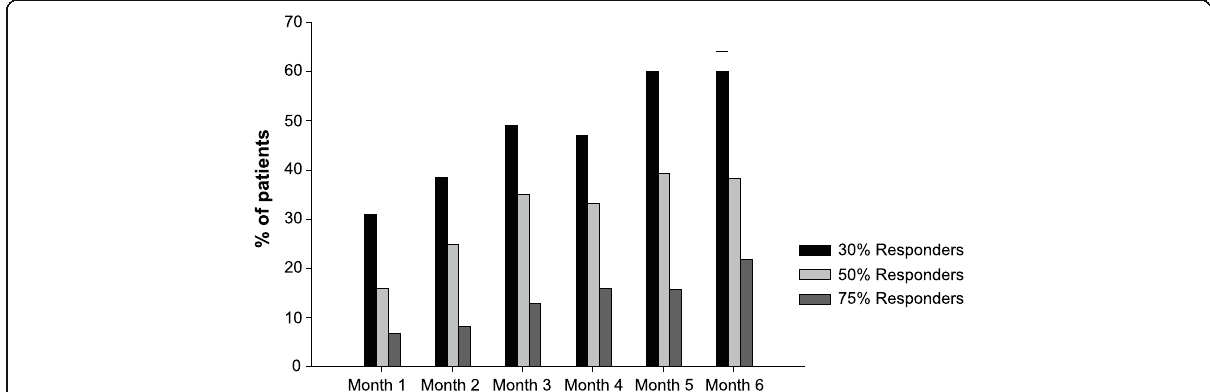
Fig. 3 Monthly responders rates: Percentage of patients who achieved at least a 30%, 50% or 75% reduction in monthly migraine days per month, post-erenumab treatment